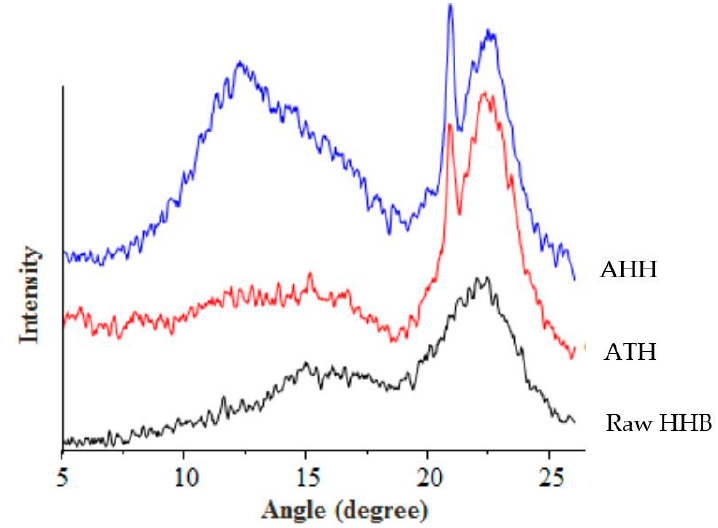
Figure 3. X-ray diffraction pattern of raw HHB (black), ATH (red), and AHH (blue).